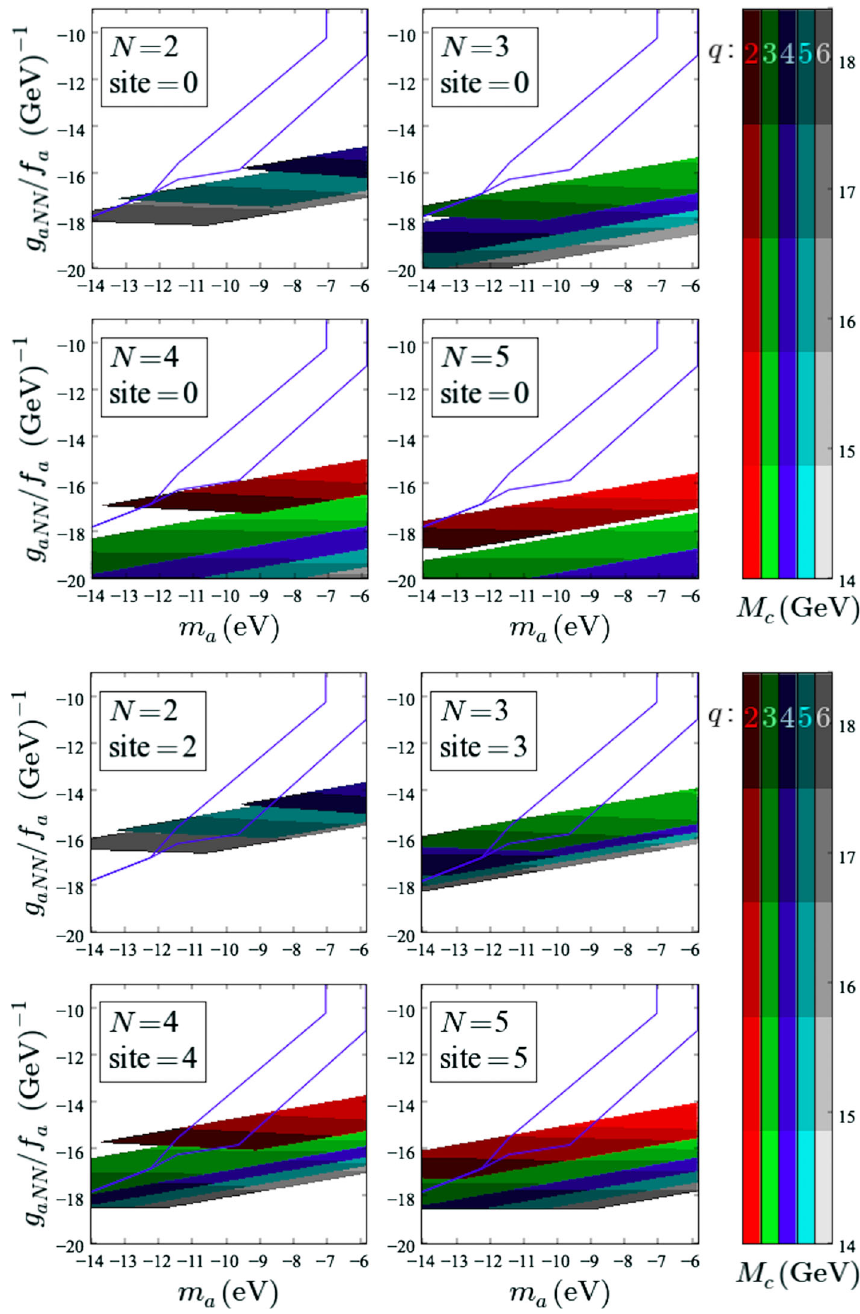
Fig. 8 Sensitivity of CASPEr-Wind to the ALPs (colored regions indicate axions suitable to saturate the DM relic density, detection happens in the upper left part of the plot, blue lines are identical to those of Fig. 5, all axes are